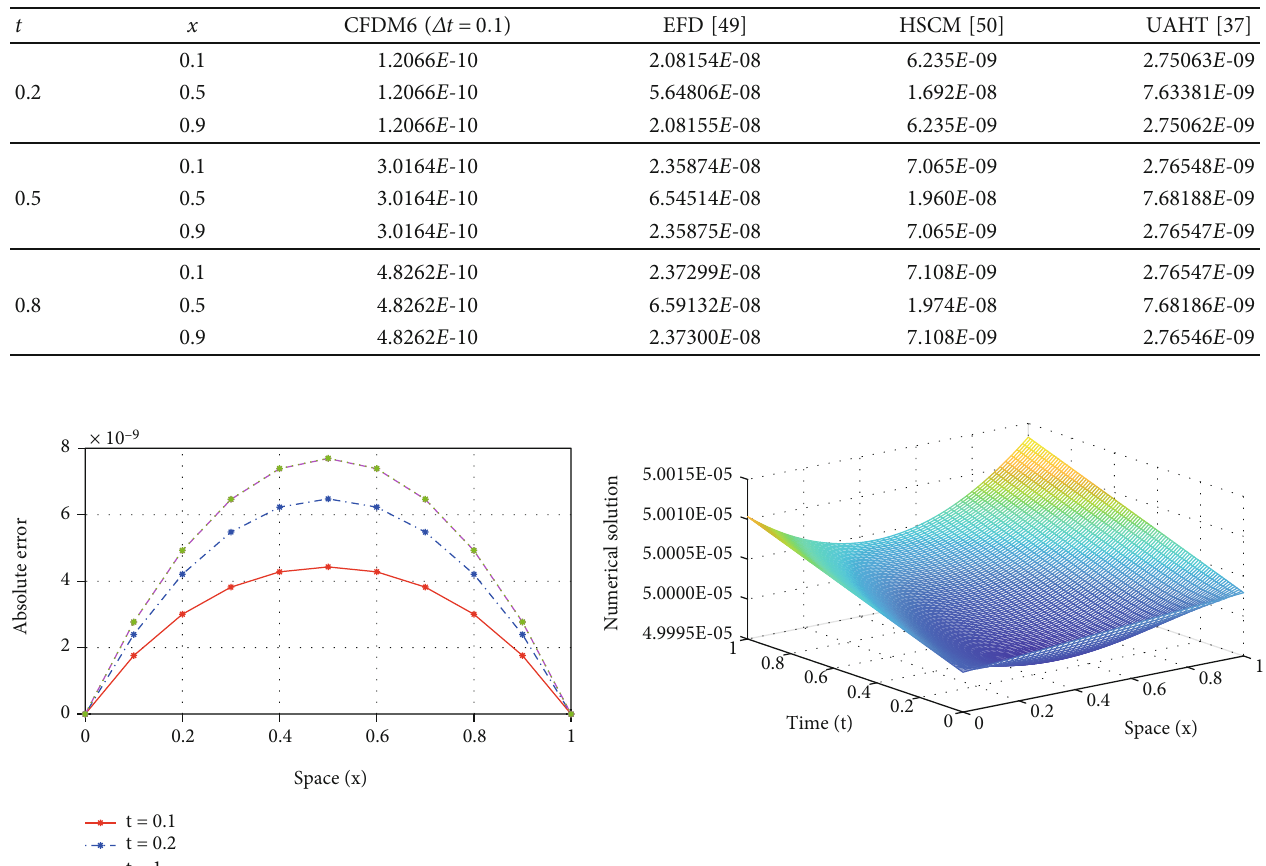
Table 10: Comparison of absolute error of Example 6 with β = 5 , γ = 10 , η = 0 : 00001 , δ = 2 , h = 0 : 1 , and Δ t = 0 : 0001 .